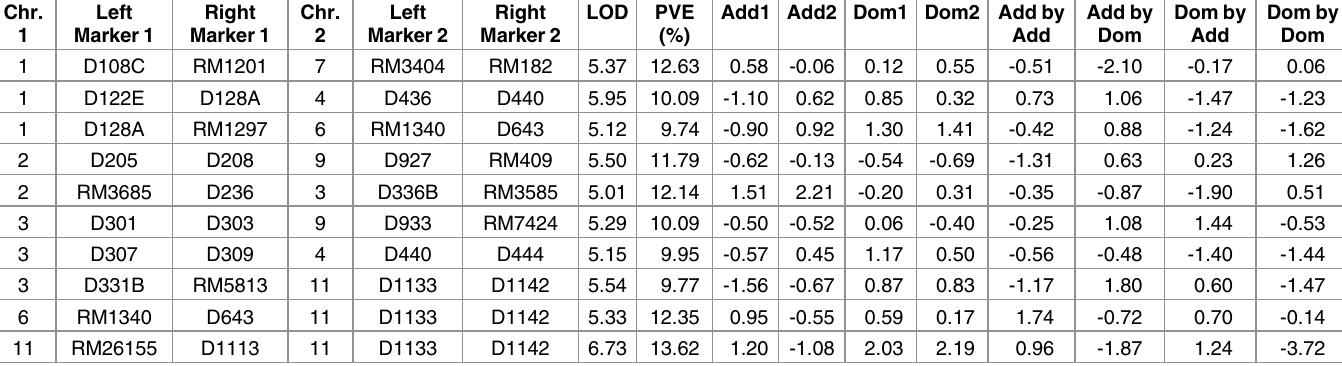
Table 4. Pairs of digenic epistatic loci detected in the F 3 population, derived from ‘Lemont’ × ‘Yangdao 4’, and grown in 2012in Hainan, by using inclusive composite interval mapping. Chr. Left Right 1 Marker 1 Marker 1